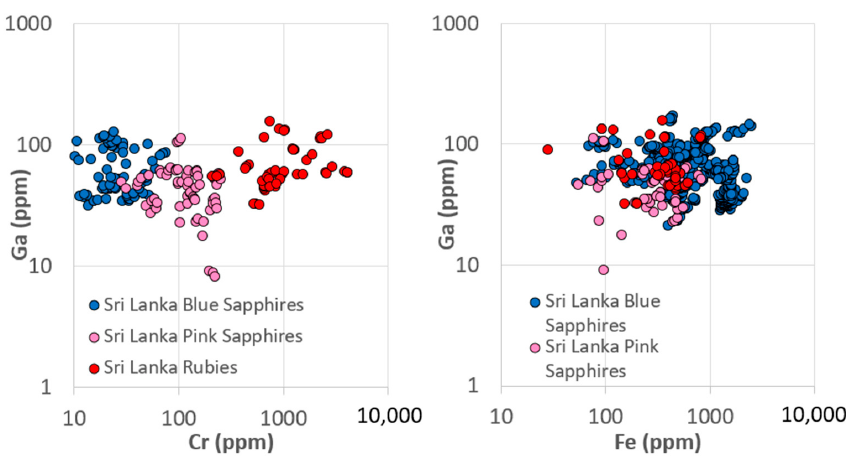
Figure 8. Trace element plots of blue and pink sapphires and rubies from Sri Lanka showing their characteristic trace element ranges.